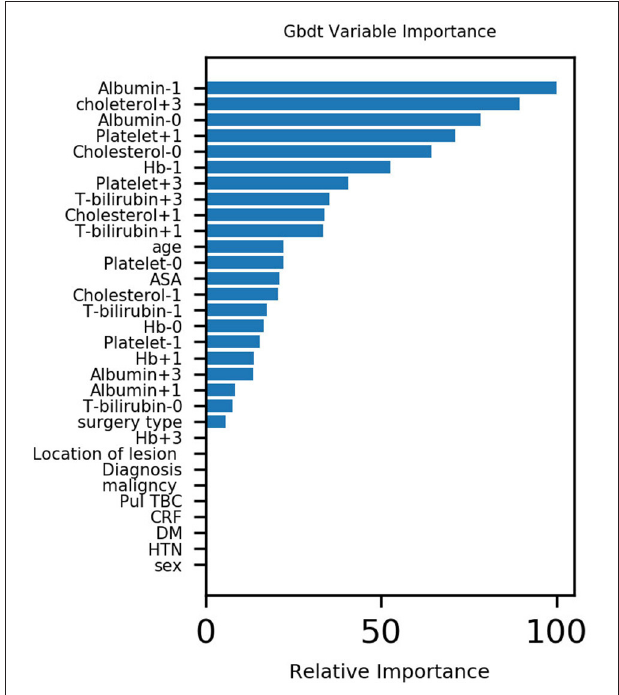
FIGURE 1 | Variable importance of features included in machine learning algorithms for predicting pulmonary